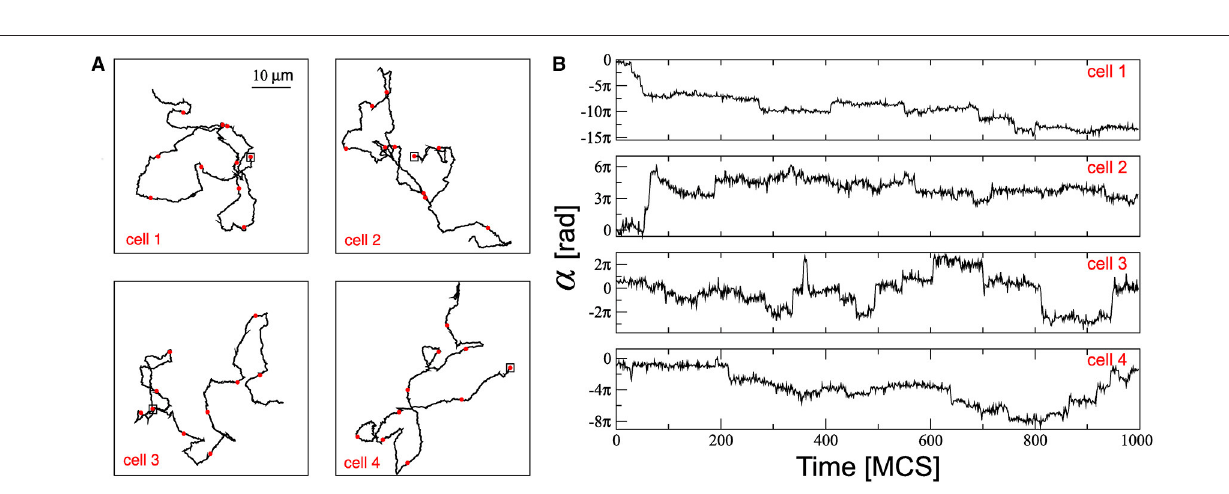
FIGURE 2 | (A) The trajectories are marked off with red circles each 100 MCS and the squares correspond to the positions of each cell at t = 0 MCS. (B) Temporal course of the cell displacement angles α associated with the trajectories depicted on the left panels . Parameters used: ρ = 0.2, τ = 10 MCS, and φ =